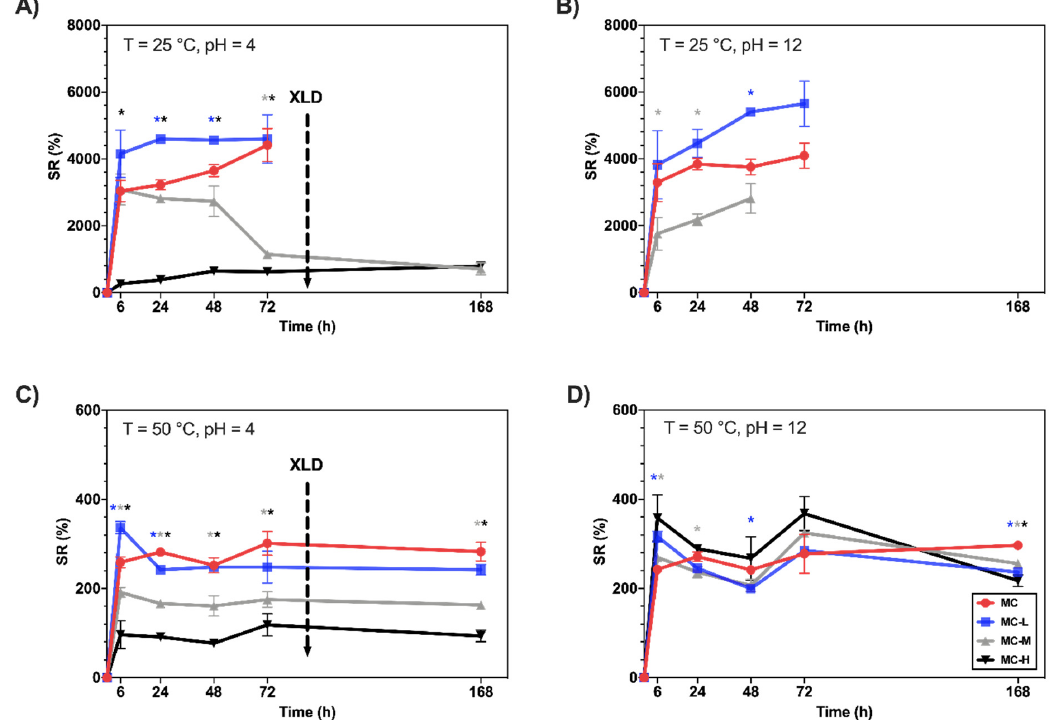
Figure 2. SR (%) vs. time of MC hydrogels in NSS at T = 25 °C and ( A ) pH = 4 or ( B ) pH = 12; at T = 50 °C and ( C ) pH = 4 or ( D ) pH = 12. * = p < 0.05 compared to MC control (* = MC vs. MC-L, * = MC vs. MC-M, * = MC vs. MC-H).